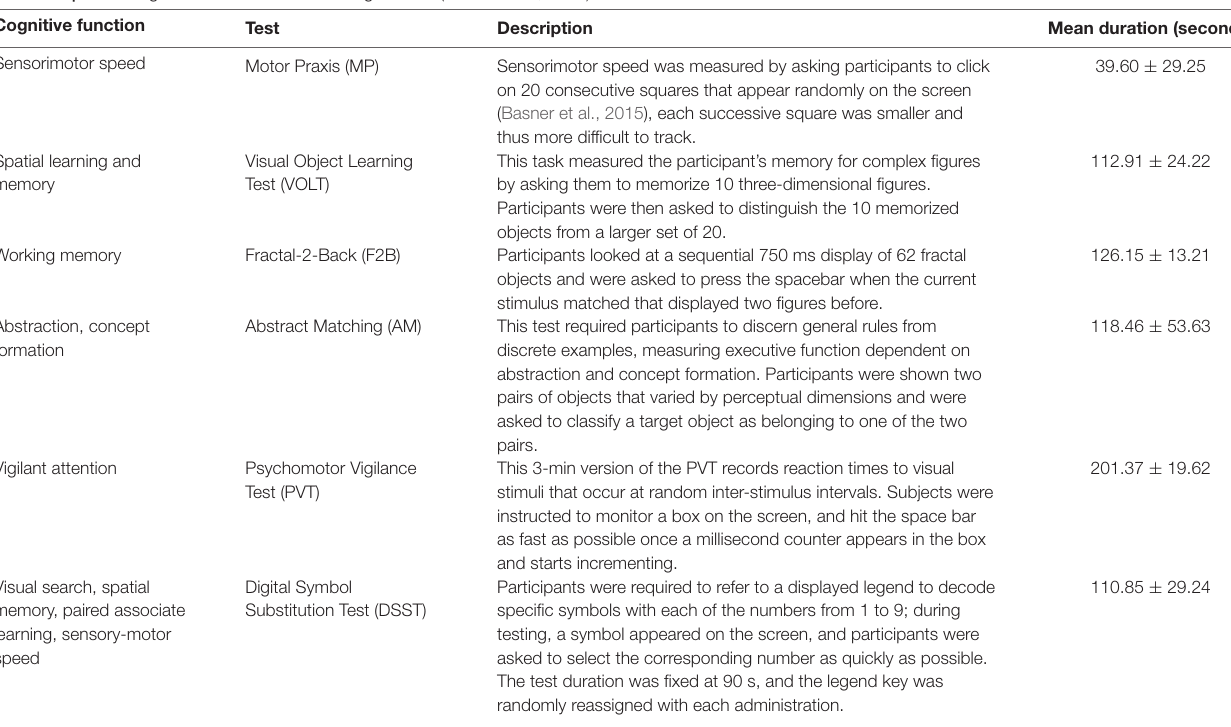
TABLE 1 | Neurocognitive tests within one testing session (Basner et al., 2015). Cognitive